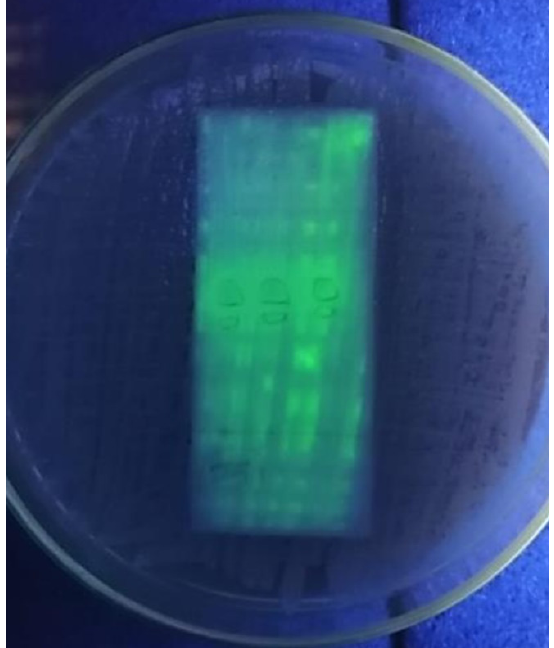
Figure A3. TLC-DB with anticandidal activity, developed in a solvent mixture of petroleum ether: EtOAc (9.3:0.7, v/v ) and examined under UV at 365 nm.